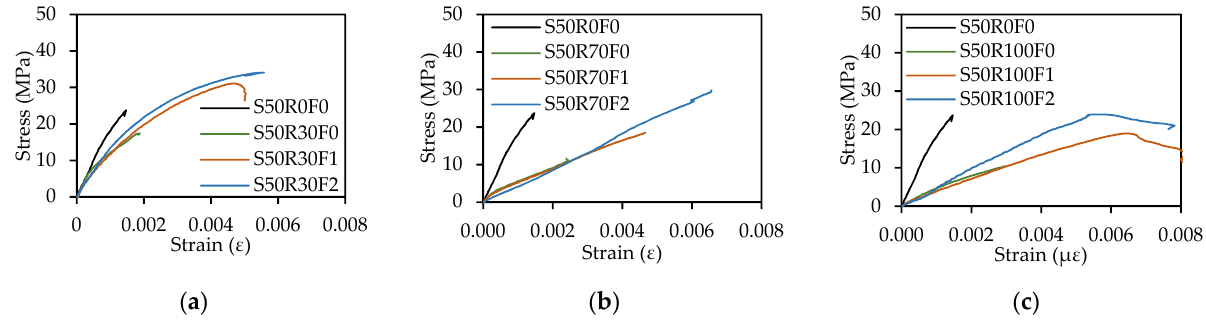
Figure 11. Typical compression stress-strain curves of RCA alkali-activated slag-fly ash (1:1) concrete mixtures with RCA replacement of ( a ) 30%, ( b ) 70%, and ( c ) 100%.